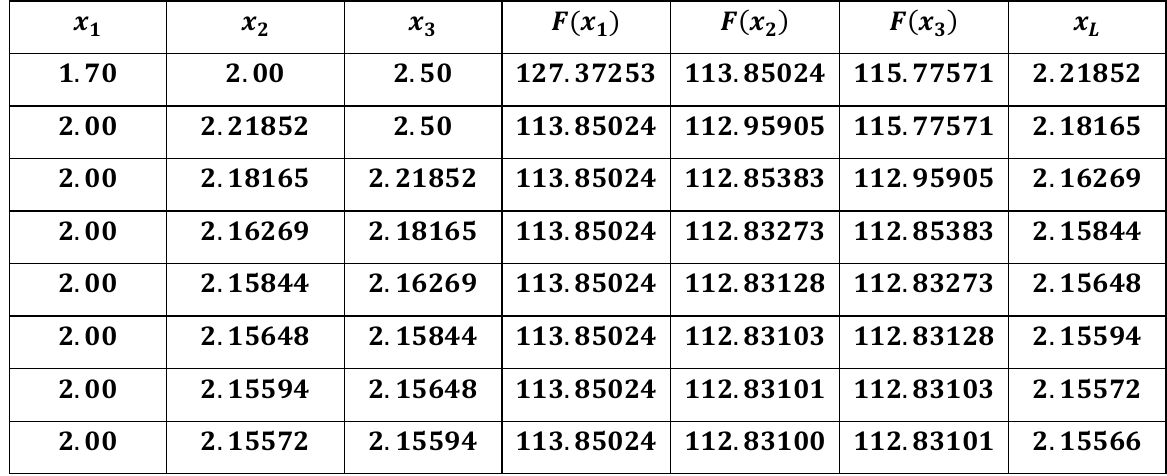
Table 1. Optimization of cost by parabolic method ) 𝑭(𝒙 ) 𝒙 𝒙 𝒙 𝒙 𝑭(𝒙 ) 𝑭(𝒙 𝟏 𝟐 𝟑 𝟏 𝟐 𝟑 𝑳 𝟏. 𝟕𝟎 𝟐. 𝟎𝟎 𝟐. 𝟓𝟎 𝟏𝟐𝟕. 𝟑𝟕𝟐𝟓𝟑 𝟏𝟏𝟑. 𝟖𝟓𝟎𝟐𝟒 𝟏𝟏𝟓. 𝟕𝟕𝟓𝟕𝟏 𝟐. 𝟐𝟏𝟖𝟓𝟐 𝟐. 𝟎𝟎 𝟐. 𝟐𝟏𝟖𝟓𝟐 𝟐. 𝟓𝟎 𝟏𝟏𝟑. 𝟖𝟓𝟎𝟐𝟒 𝟏𝟏𝟐. 𝟗𝟓𝟗𝟎𝟓 𝟏𝟏𝟓. 𝟕𝟕𝟓𝟕𝟏 𝟐. 𝟏𝟖𝟏𝟔𝟓 𝟐. 𝟎𝟎 𝟐. 𝟏𝟖𝟏𝟔𝟓 𝟐. 𝟐𝟏𝟖𝟓𝟐 𝟏𝟏𝟑. 𝟖𝟓𝟎𝟐𝟒 𝟏𝟏𝟐. 𝟖𝟓𝟑𝟖𝟑 𝟏𝟏𝟐. 𝟗𝟓𝟗𝟎𝟓 𝟐. 𝟏𝟔𝟐𝟔𝟗 𝟐. 𝟎𝟎 𝟐. 𝟏𝟔𝟐𝟔𝟗 𝟐. 𝟏𝟖𝟏𝟔𝟓 𝟏𝟏𝟑. 𝟖𝟓𝟎𝟐𝟒 𝟏𝟏𝟐. 𝟖𝟑𝟐𝟕𝟑 𝟏𝟏𝟐. 𝟖𝟓𝟑𝟖𝟑 𝟐. 𝟏𝟓𝟖𝟒𝟒 𝟐. 𝟎𝟎 𝟐. 𝟏𝟓𝟖𝟒𝟒 𝟐. 𝟏𝟔𝟐𝟔𝟗 𝟏𝟏𝟑. 𝟖𝟓𝟎𝟐𝟒 𝟏𝟏𝟐. 𝟖𝟑𝟏𝟐𝟖 𝟏𝟏𝟐. 𝟖𝟑𝟐𝟕𝟑 𝟐. 𝟏𝟓𝟔𝟒𝟖 𝟐. 𝟎𝟎 𝟐. 𝟏𝟓𝟔𝟒𝟖 𝟐. 𝟏𝟓𝟖𝟒𝟒 𝟏𝟏𝟑. 𝟖𝟓𝟎𝟐𝟒 𝟏𝟏𝟐. 𝟖𝟑𝟏𝟎𝟑 𝟏𝟏𝟐. 𝟖𝟑𝟏𝟐𝟖 𝟐. 𝟏𝟓𝟓𝟗𝟒 𝟐. 𝟎𝟎 𝟐. 𝟏𝟓𝟓𝟗𝟒 𝟐. 𝟏𝟓𝟔𝟒𝟖 𝟏𝟏𝟑. 𝟖𝟓𝟎𝟐𝟒 𝟏𝟏𝟐. 𝟖𝟑𝟏𝟎𝟏 𝟏𝟏𝟐. 𝟖𝟑𝟏𝟎𝟑 𝟐. 𝟏𝟓𝟓𝟕𝟐 𝟐. 𝟎𝟎 𝟐. 𝟏𝟓𝟓𝟕𝟐 𝟐. 𝟏𝟓𝟓𝟗𝟒 𝟏𝟏𝟑. 𝟖𝟓𝟎𝟐𝟒 𝟏𝟏𝟐. 𝟖𝟑𝟏𝟎𝟎 𝟏𝟏𝟐. 𝟖𝟑𝟏𝟎𝟏 𝟐.